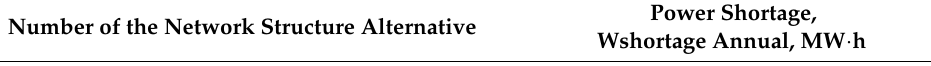
Table 7. The value of a power shortage for alternative structures of the flexible distribution network. Number of the Network Structure Alternative